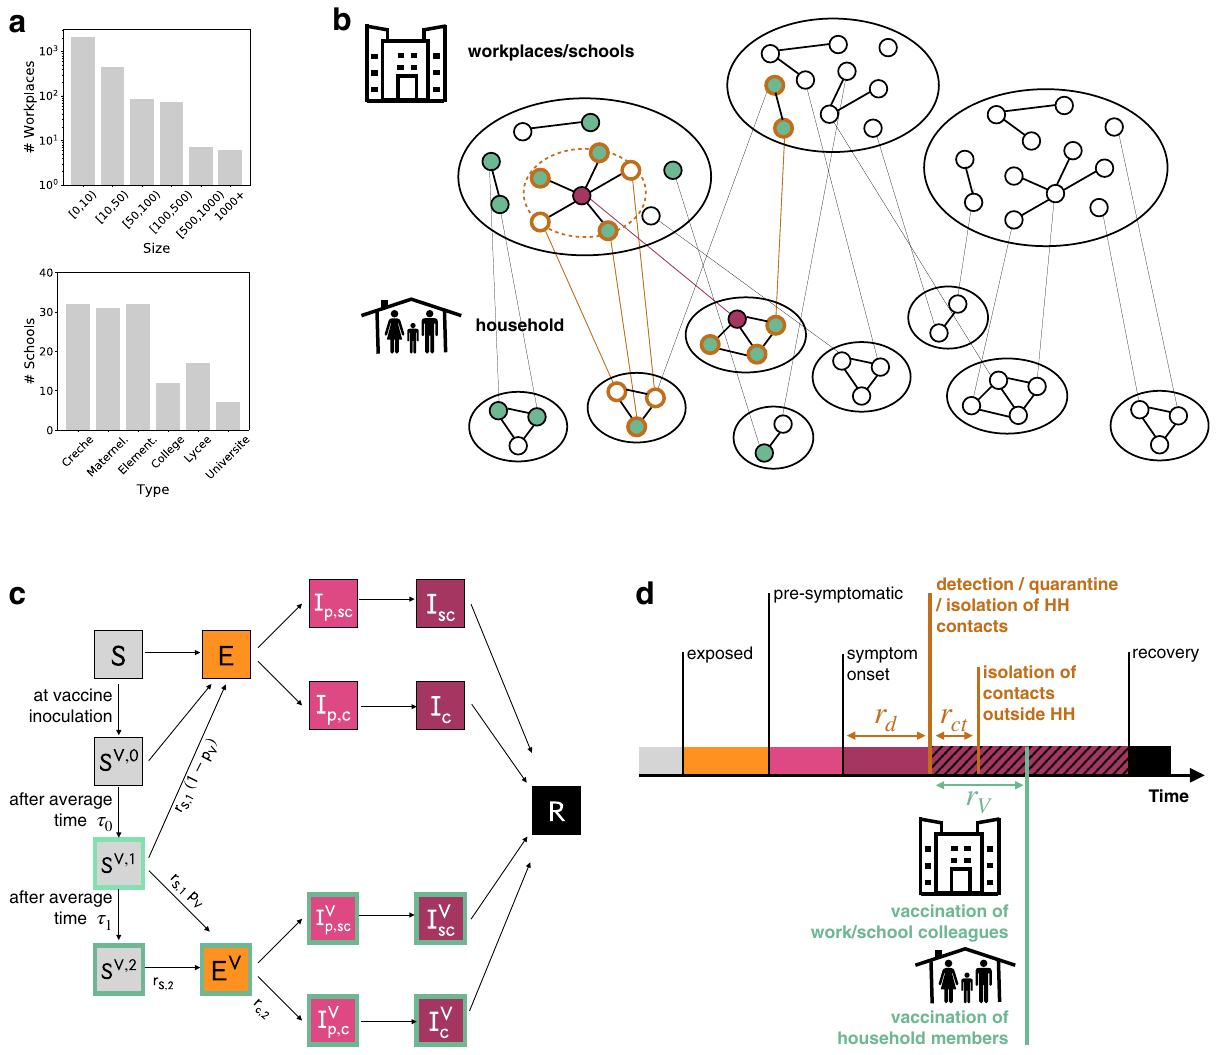
Fig. 1 Modelling reactive vaccination. a Distribution of workplace size and of school type for the municipality of Metz (Grand Est region, France), used in the simulation study. b Schematic representation of the population structure, the reactive vaccination and contact tracing. The synthetic population is represented as a dynamic multi-layer network, where layers encode contacts in household, workplace, school, community and transport. In the fi gure, school and workplace layers are collapsed and community and transport are not displayed for the sake of visualisation. Nodes repeatedly appear on both the household and the workplace/school layer. The identi fi cation of an infectious individual (in purple in the fi gure) triggers the detection and isolation of his/her contacts (nodes with orange border) and the vaccination of individuals attending the same workplace/school and belonging to the same household who accept to be vaccinated (green). c Compartmental model of COVID-19 transmission and vaccination. Description of the compartments is reported on the Methods section. d Timeline of events following infection for a case that is detected in a scenario with reactive vaccination. For panels c , d transition rate parameters and their values are described in the Methods and in the Supplementary